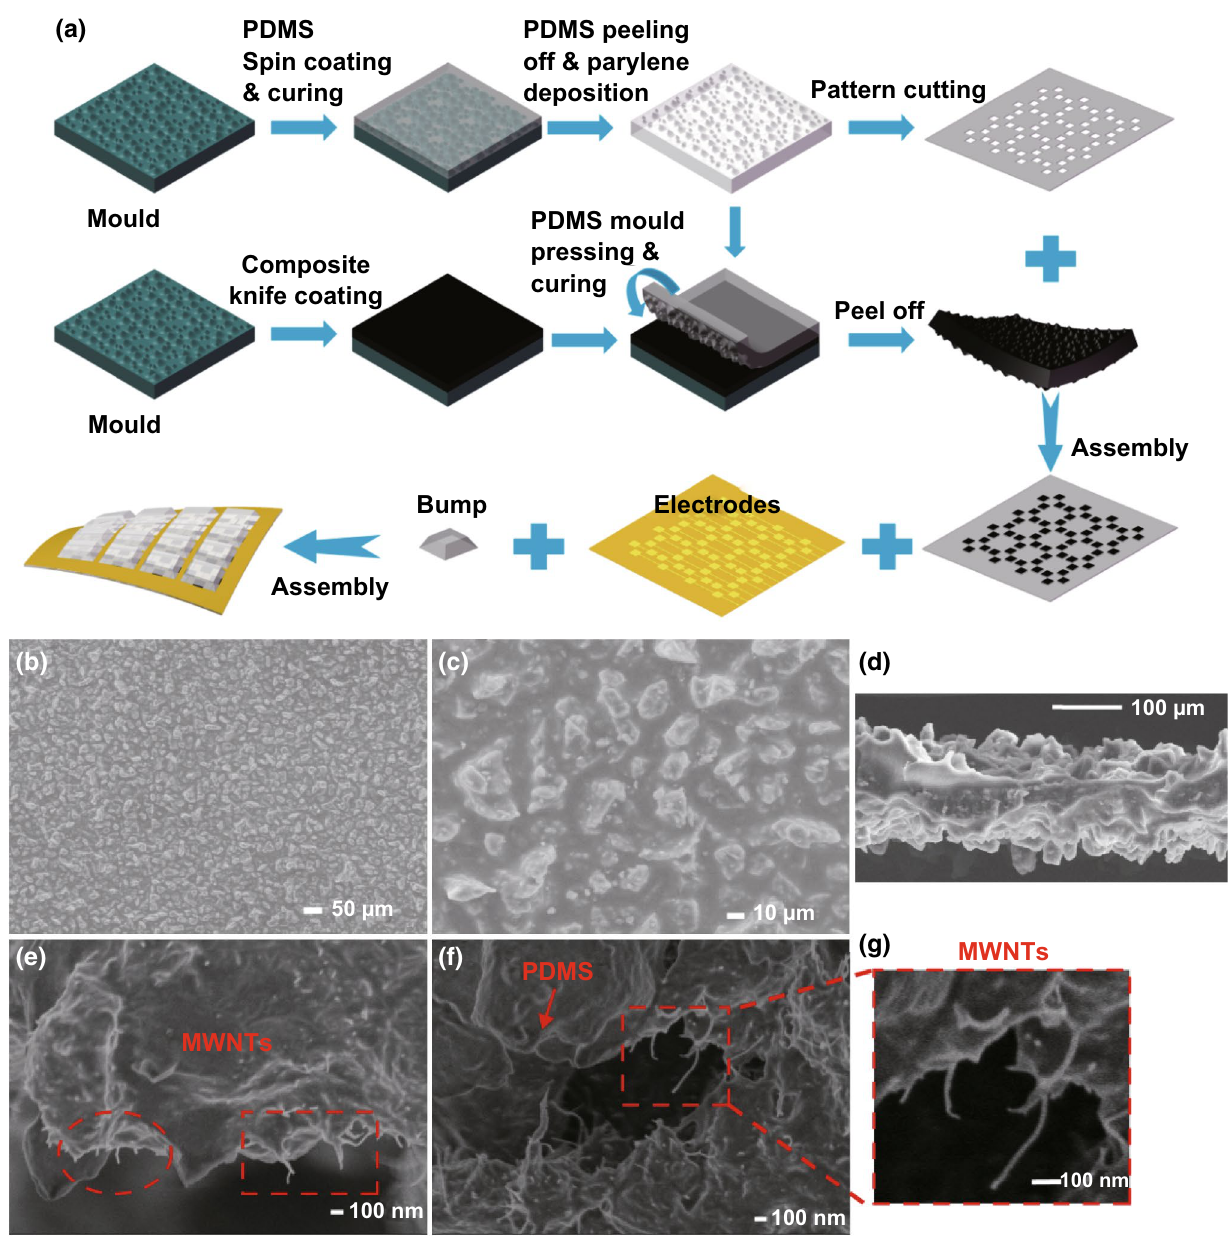
Fig. 2 a Schematic of the fabrication details of flexible tactile sensor array. b , c SEM images in top view of surface structure of nanocomposites at different magnifications. d Side view of the nanocomposite film with double-sided rough surface. e , f SEM images of porous structures in the nanocomposite at high magnification. g Magnified view of individual CNTs in